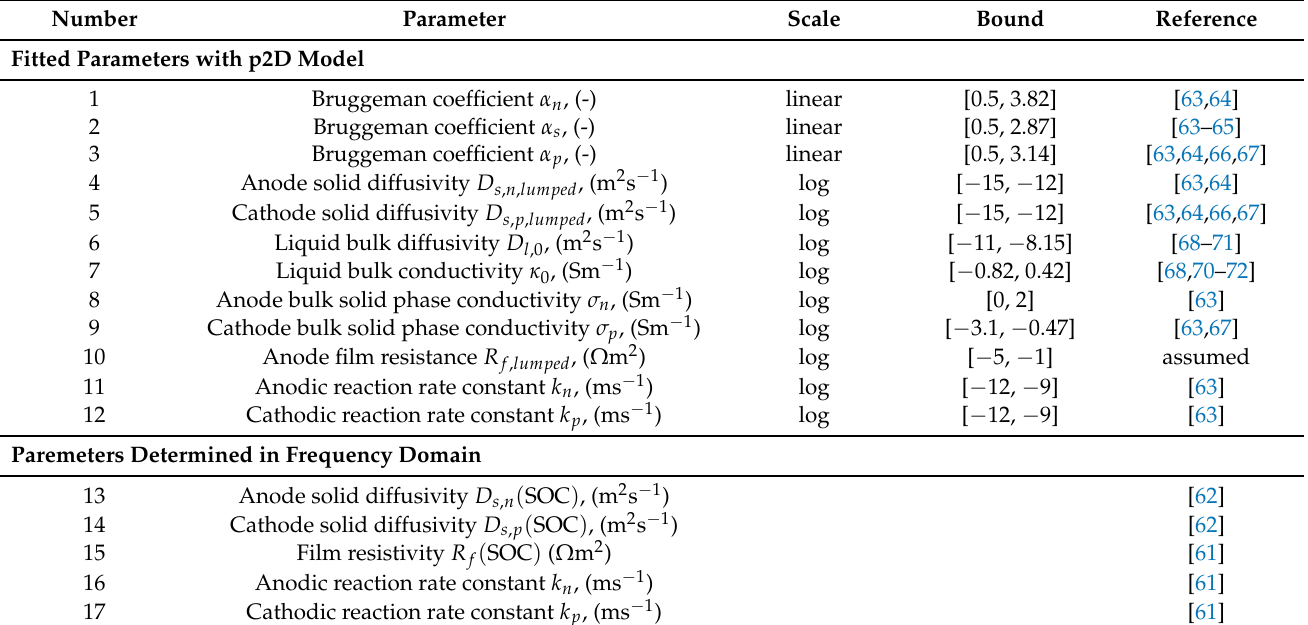
Table 4. Summary of all estimated and substituted parameters in the time and frequency